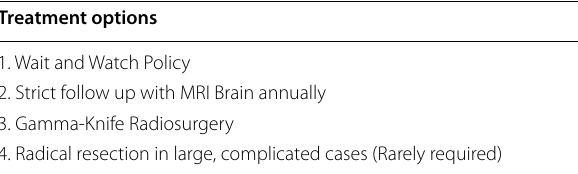
Table 2 How to treat oculomotor schwannoma Treatment